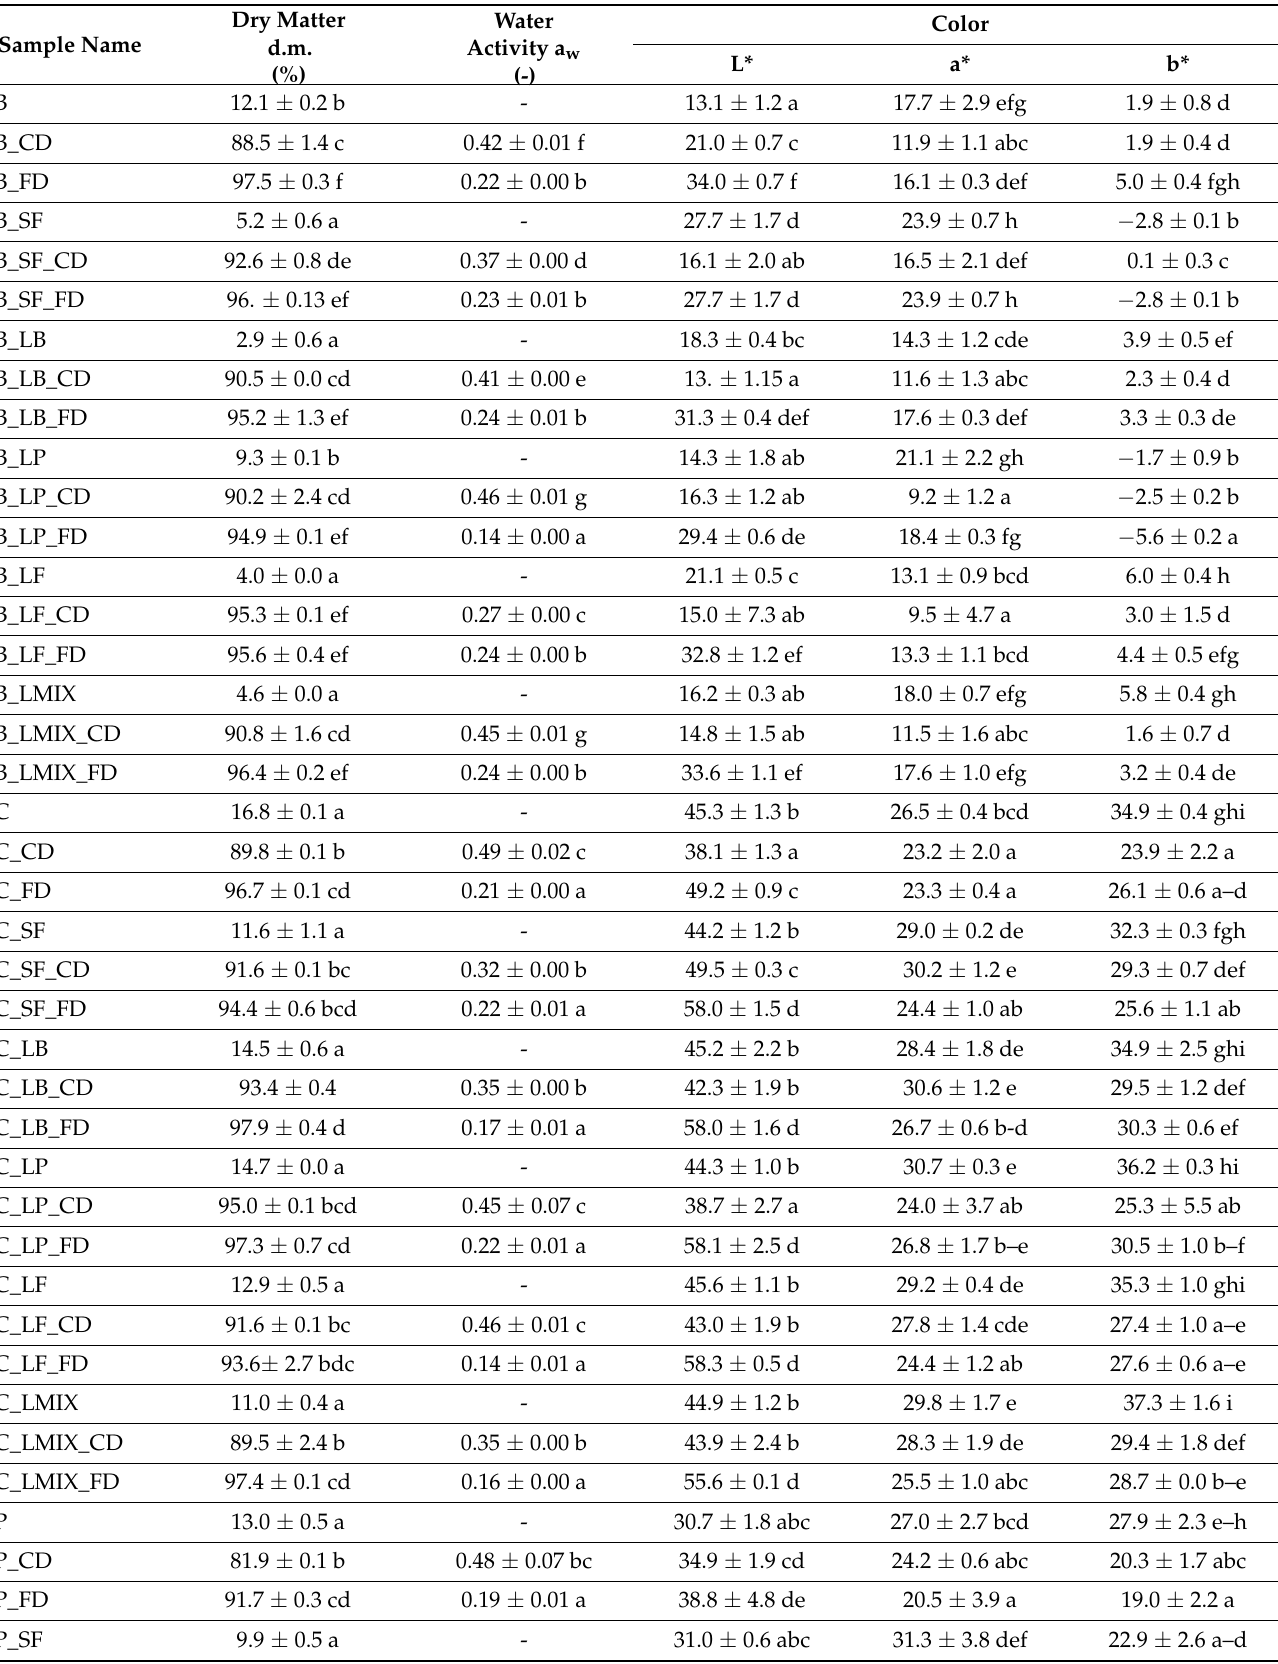
Table 1. General properties of beetroot, carrot and red pepper